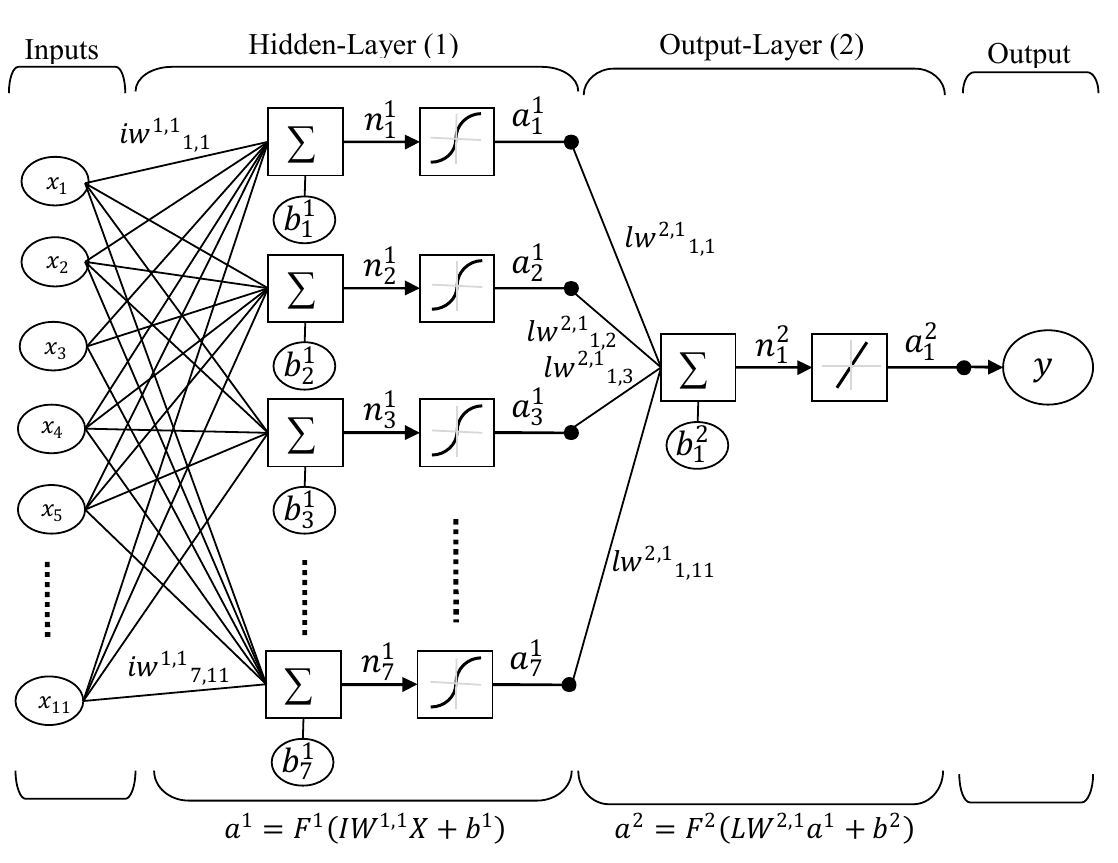
Figure 1. Structure of the ANN model.